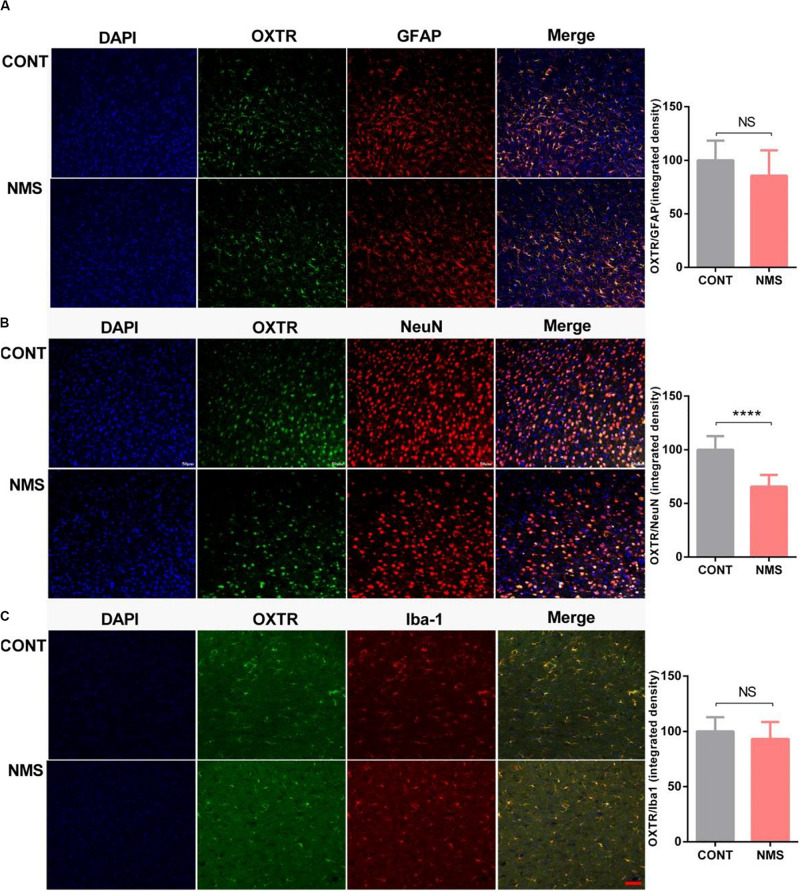
Expression of OXTR in neuronal cells, including neuron, microglia, and astrocyte in mPFC of long-term NMS rats. (A–C) Quantification of OXTR positive neural cells (integrated densities; NeuN for neuron marker; iBA1 for microglia marker; GFAP for astrocyte marker) in mPFC slices of different animal groups using immunofluorescence staining. Double immunolabeled surface areas of OXTR/GFAP (A), OXTR/NeuN (B), and OXTR/Iba-1 (C) from the mPFC, which are indicated in white lines, were quantified using the ImageJ Program (two-tailed unpaired t-test; t22 = 1.660 [OXTR/GFAP], P = 0.1110; t22 = 7.135 [OXTR/NeuN], P < 0.0001; t22 = 1.194 [OXTR/Iba-1], P = 0.2453; ****P < 0.0001, n.s. P > 0.05, n = 3 in each group). Data are represented as mean ± SEM. Scale bars: 50 μm.